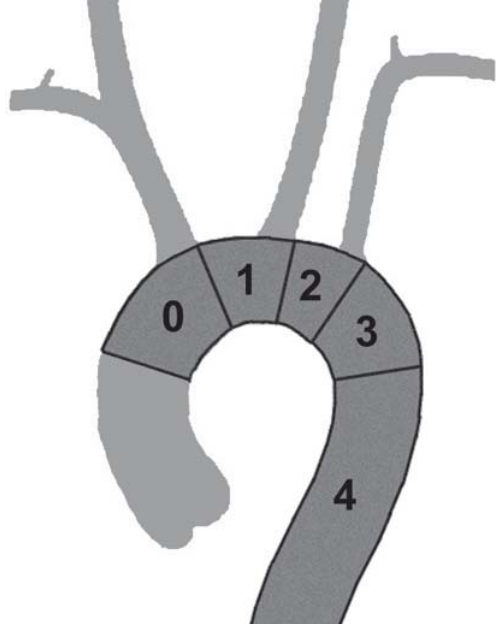
Fig. 1 – Classificação das zonas de ancoragem da aorta torácica, segundo Mitchell et al. [14]